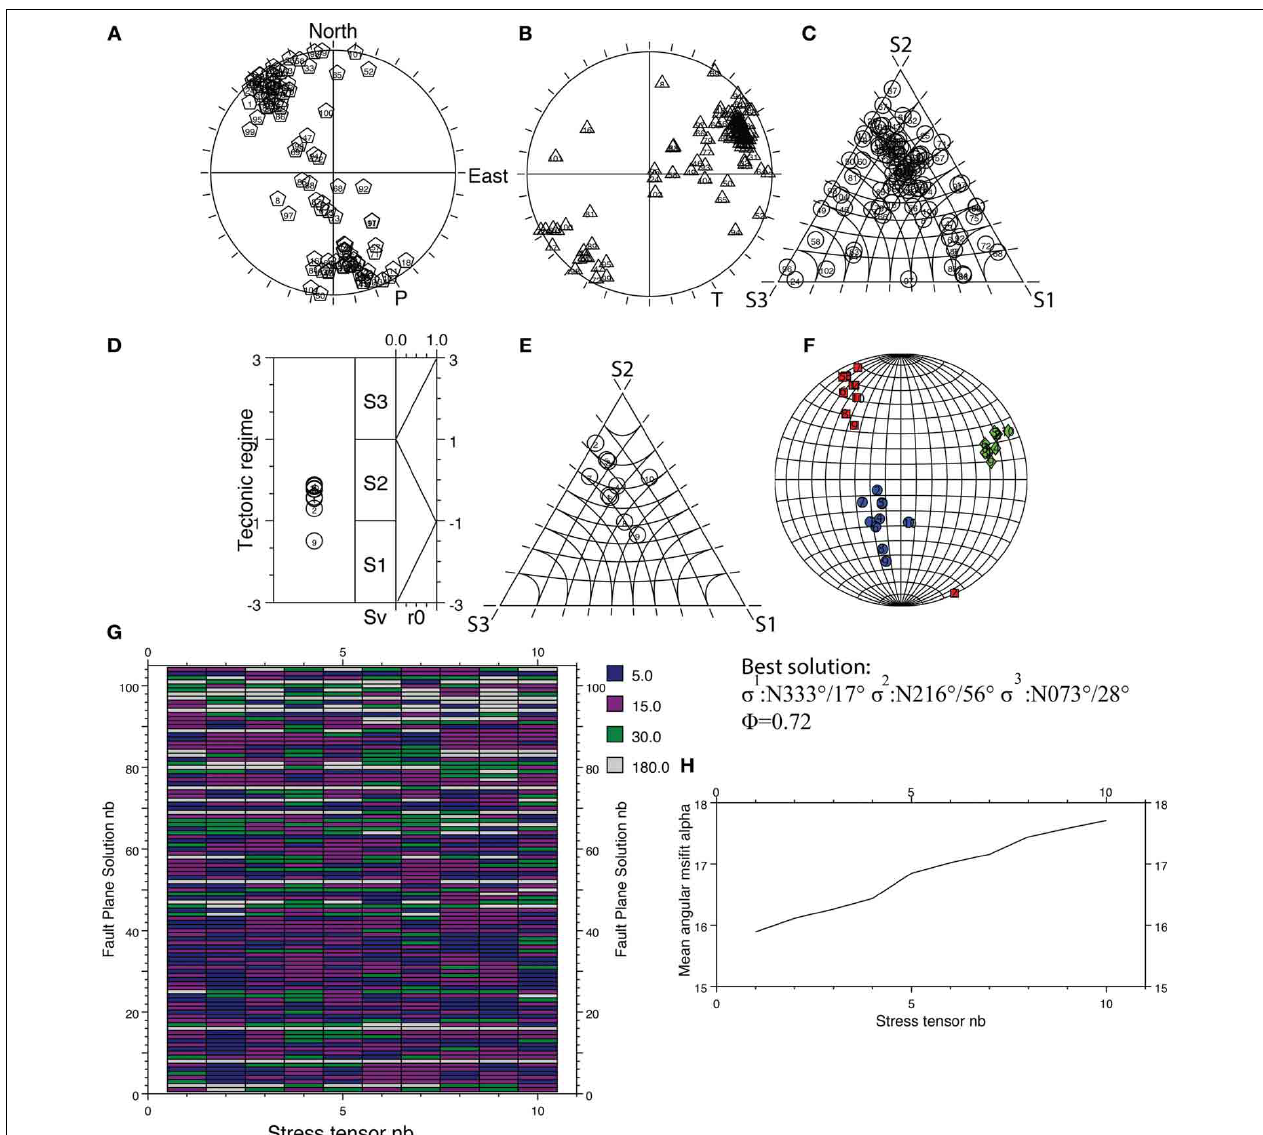
P and T-axes, red squares denote the orientation of σ 1 , blue circles σ 2 and FIGURE 10 | P, B, and T analysis and stress inversion results for the tectonic regime T1. (A) Stereographic projection lower hemisphere of green diamonds σ 3 . (G) Table of the best 10 stress tensors in ascending order (x-axis, the first one being the best one), with the individual angular P-axes, (B) Same projection for T-axes, (C) Ternary diagram for the P, B and misfit α (between the observed slip and the resolved shear stress) of each T axes, S1 = Extension, S2 = Wrench, S3 = Compression (see Figure 3 datum (y-axis). Blue cases for α > 5 ◦ , purple ones for α > 15 ◦ , and green for references). (D) Tectonic regime plot (Armijo et al., 1982; Philip, 1987; Célérier, 1995) of the 10 best stress tensors resulting from the random ones α > 30 ◦ . The gray ones shows α > 30 ◦ and then are not explained (cid:3) (cid:2) σ 2 − σ 3 . (E) Ternary diagram showing the stress search. Vertical axis, (cid:4) = by the stress tensor. (H) Average misfit α in y-axis for the 10 best stress σ 1 − σ 3 tensor numbered in plunge-axes of the 10 best stress tensors. (F) Same projection as for the